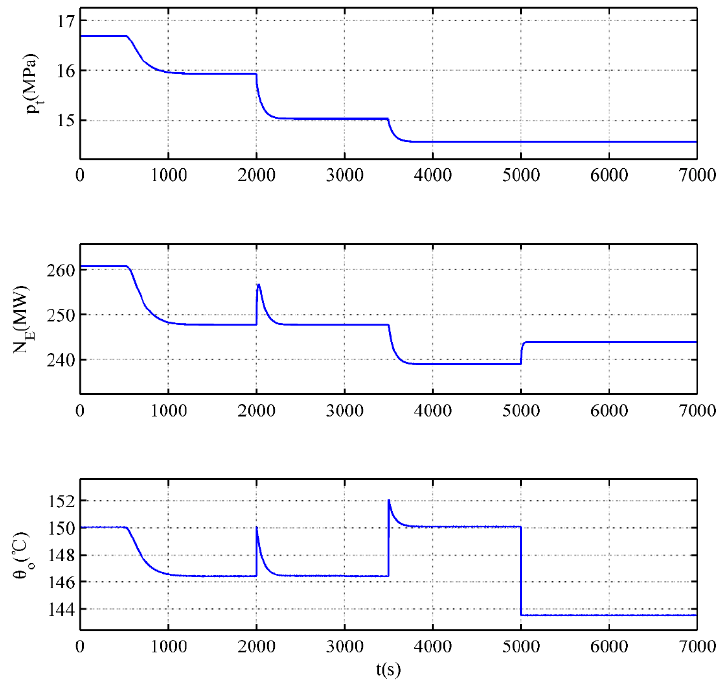
Figure 2. Curves for model outputs.